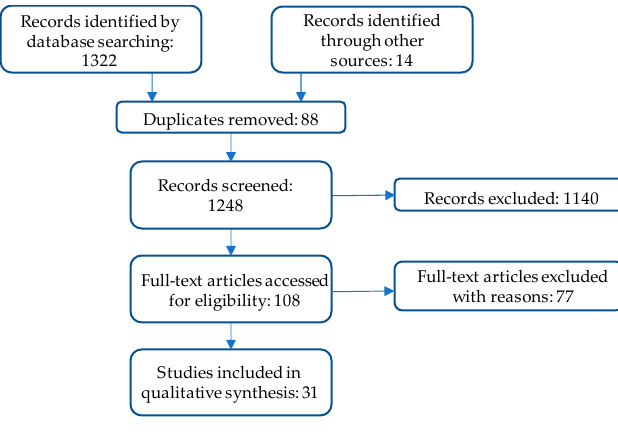
Figure 1. Study selection.